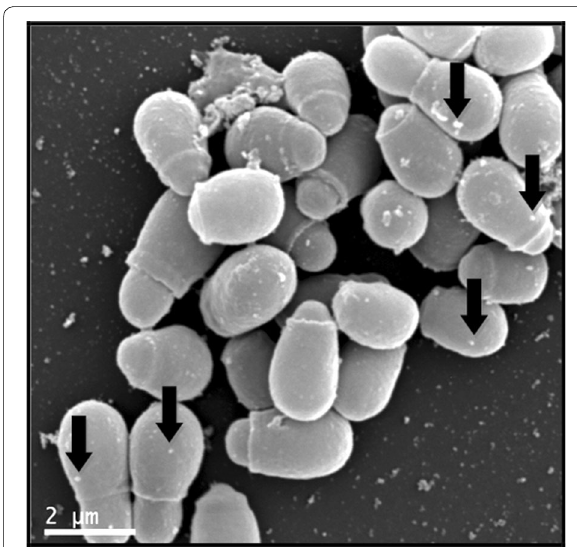
All MIC and MFC data are expressed in terms of mg/L